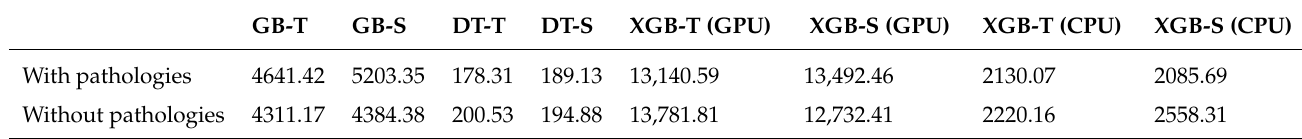
Table 4. Measured times in seconds for each method and problem.